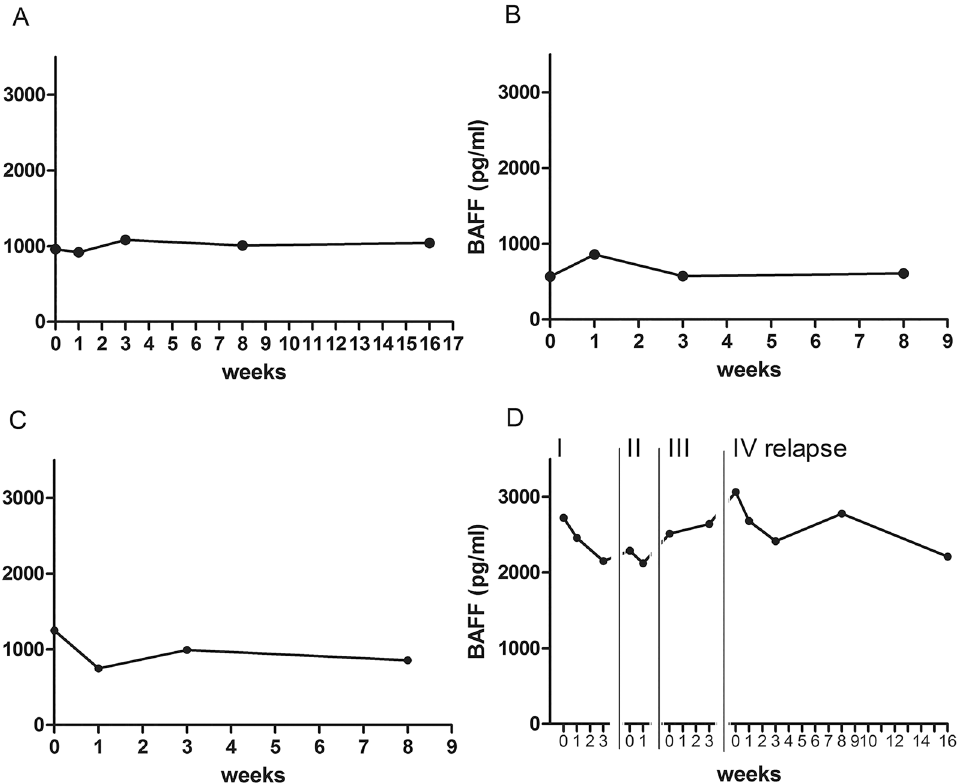
Fig 4. Examples of different patterns of plasma BAFF level changes during acute relapse in four patients with RRMS. (A) Patient with a uniform BAFF level pattern. (B) Patient with increased BAFF levels before steroid treatment. (C) Patient with decreased BAFF levels during acute relapse (before steroid treatment). (D) Patient with different patterns of BAFF levels during different relapse